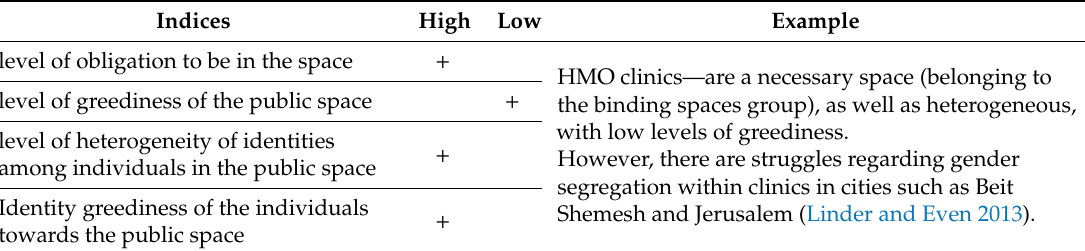
Table A9. Medium potential